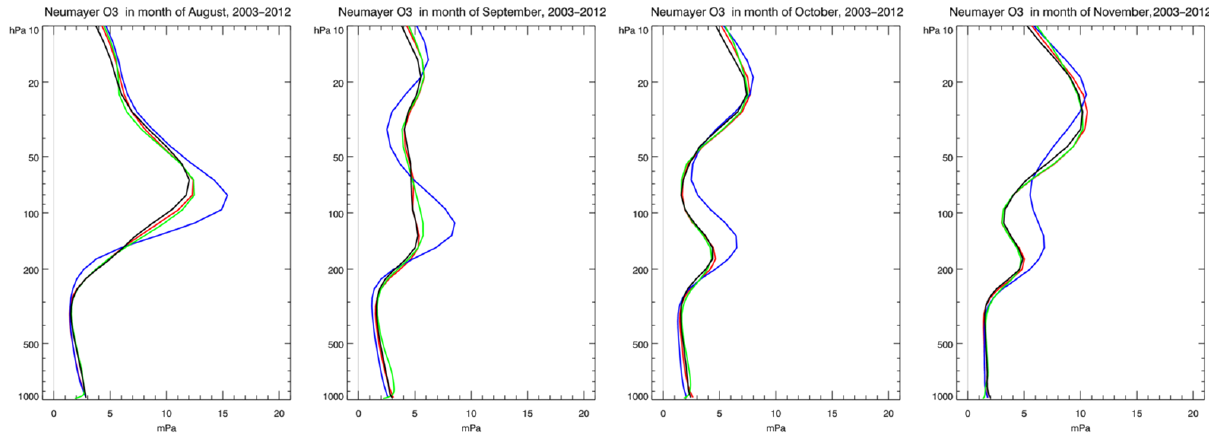
Figure 18. Monthly mean ozone profiles (mPa) at Neumayer Station from ozone sondes of CAMSiRA (red), MACCRA (green) and the CR (blue) for August to November